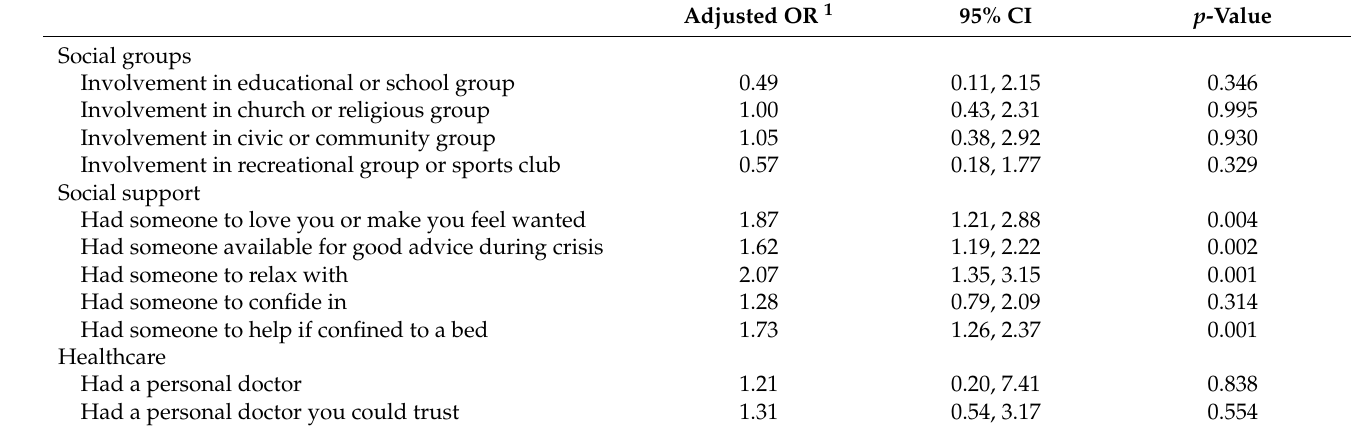
Table 4. Associations between hypothesized protective factors and having at least one ED visit in the 12 months after survey completion among survey respondents with high ACE scores (ACE ≥